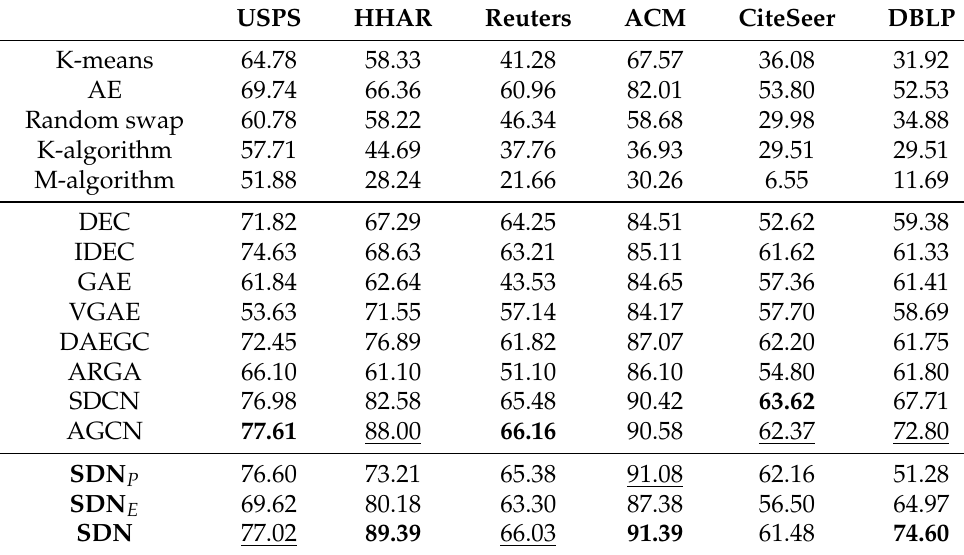
Table 8. Macro-F1 score (F1) results on six